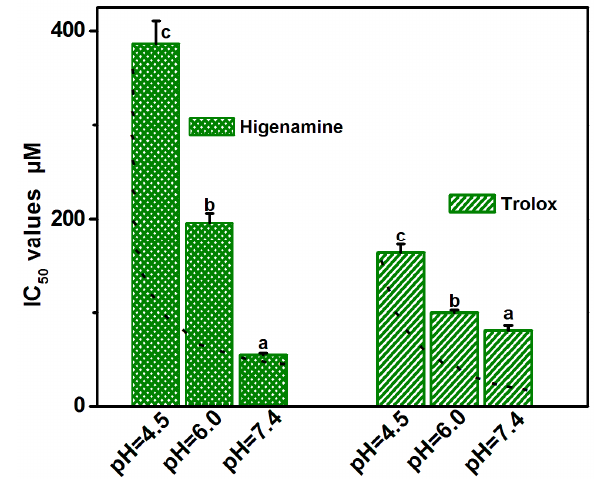
Figure 4. IC 50 values of higenamine and Trolox in 2-phenyl-4,4,5,5-tetramethylimidazoline-1-oxyl 3-oxide radical (PTIO•)-scavenging assay at pH 4.5, 6.0 and 7.4. Means values with different superscripts (a or b or c) for the same sample are significantly different ( p < 0.05).